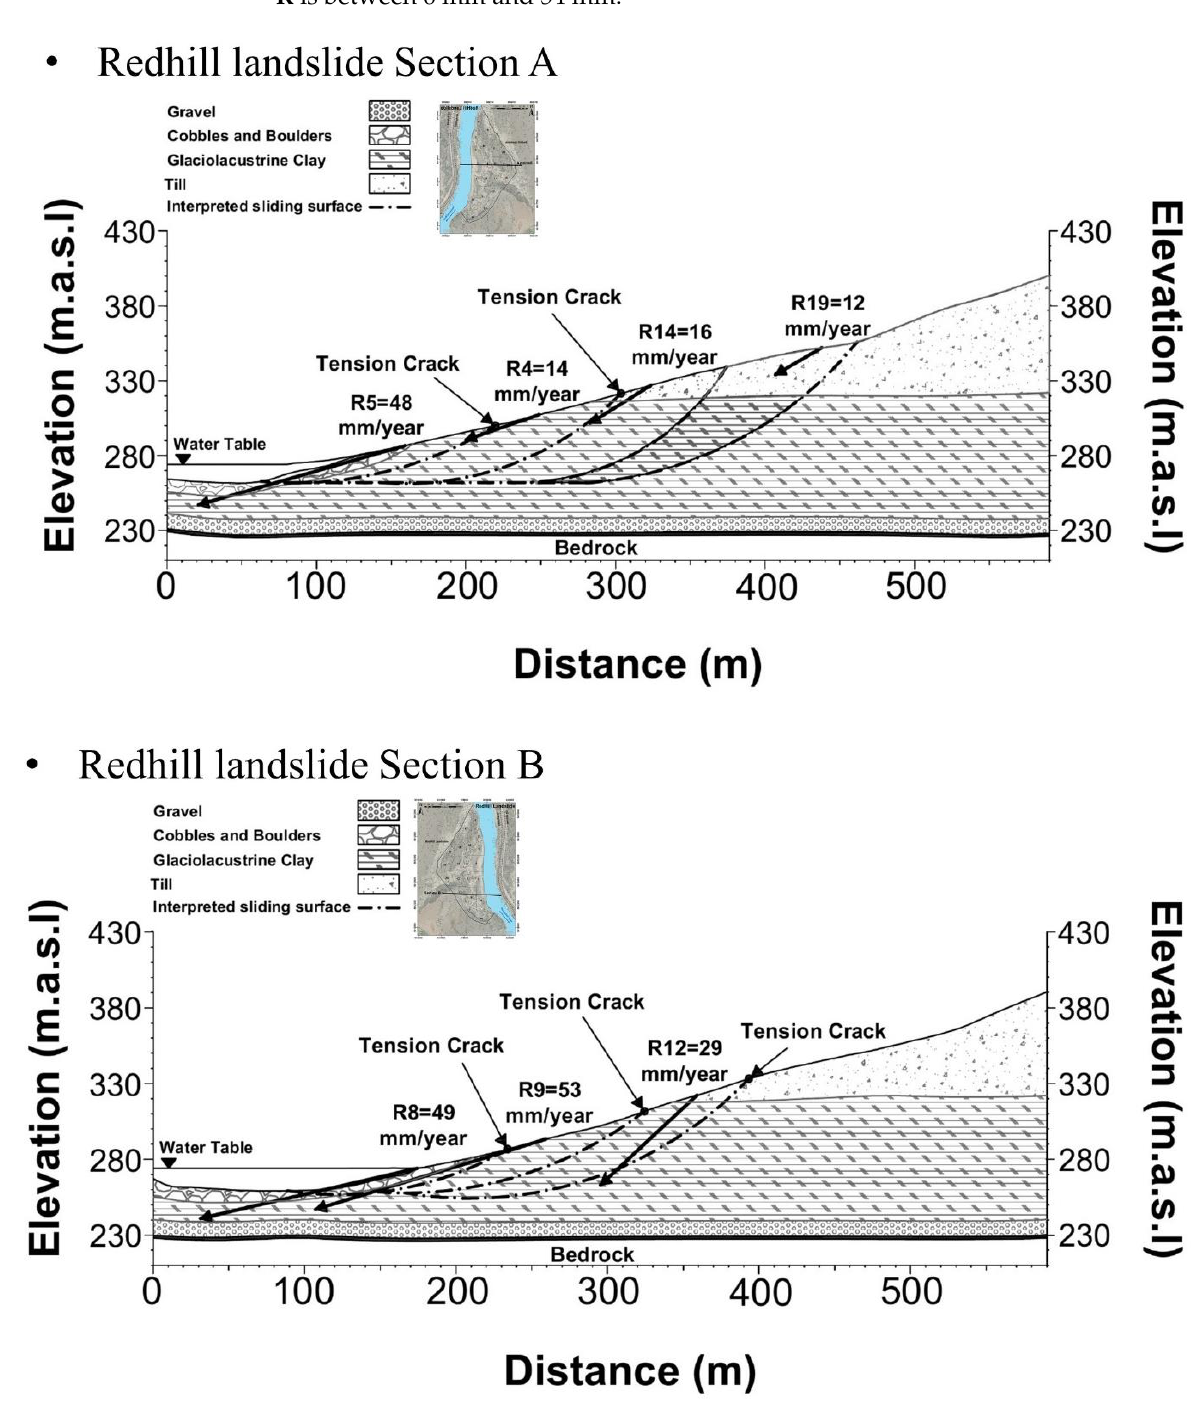
Figure 27. Calculated vertical component of R for selected sectors on the Redhill landslide.